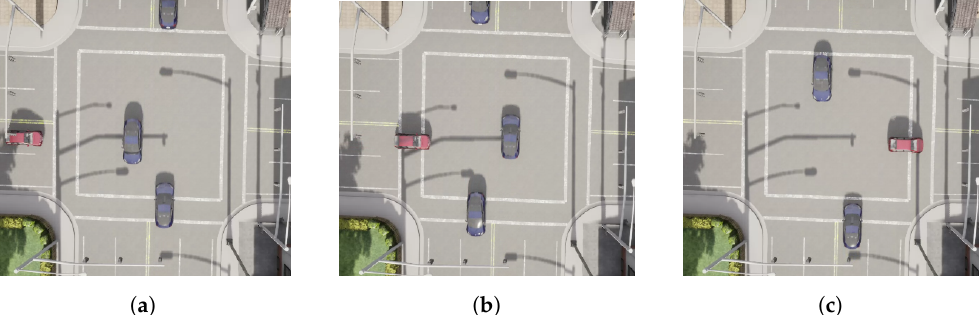
Figure 10. RL agent (red) at uncontrolled intersection. Velocity (v), action (a) and time (t) are described for each frame. ( a ) v = 3; a = stop; t = 8.5 ( b ) v = 4; a = drive; t = 12.7 ( c ) v = 5; a = drive; t =